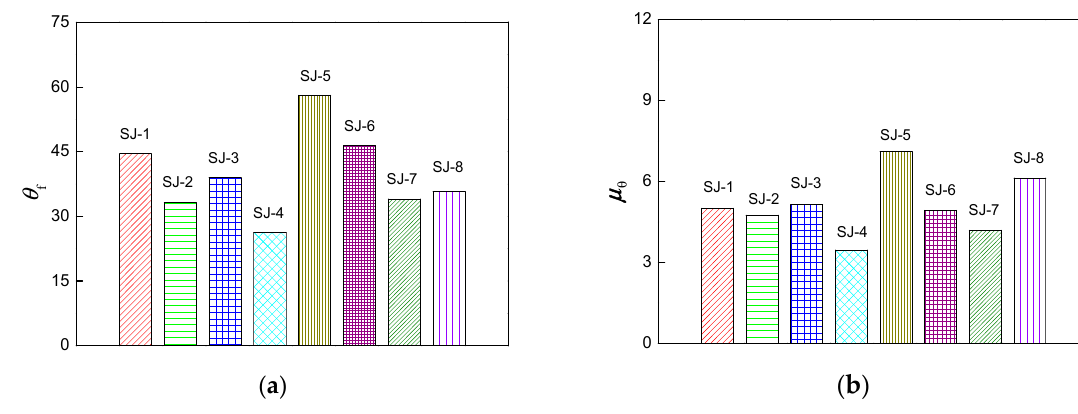
Figure 17. Comparison of the ( a ) Rotational capacity and ( b ) Ductility coe ffi cient of the